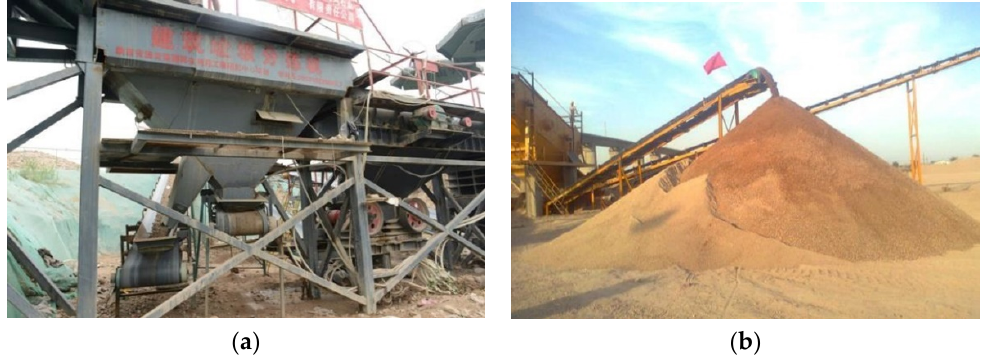
Figure 16. Brick separation technology and upgraded recycled aggregates production: ( a ) Brick separation device; ( b ) Purified recycled aggregate.